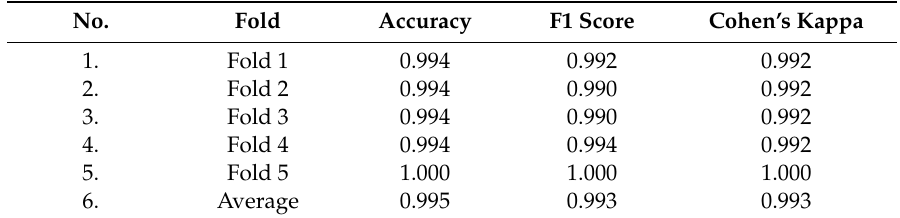
Table 4. Experiment results.